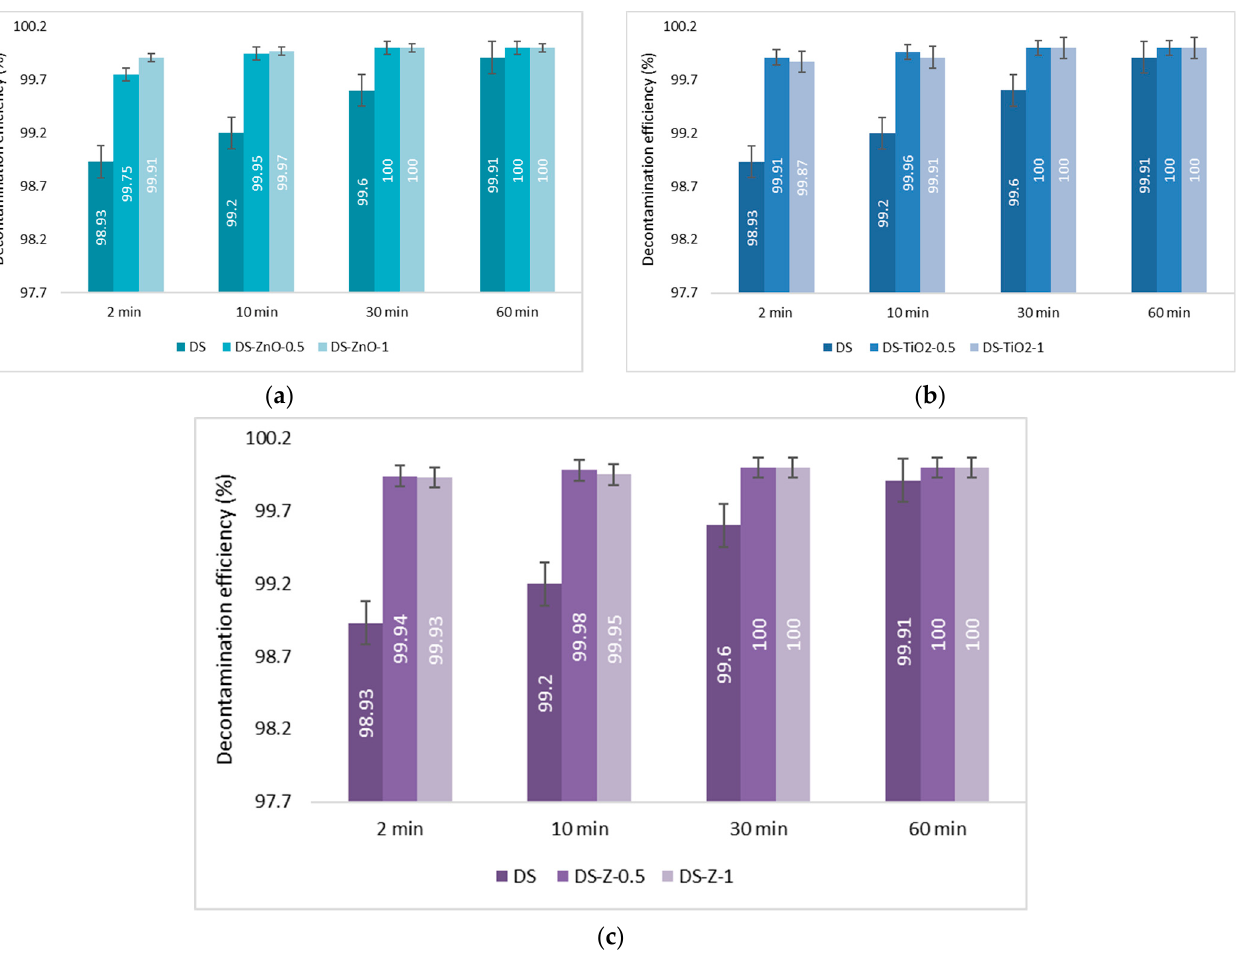
Figure 11. Decontamination degrees (%) of soman (GD) obtained for decontamination formulations containing: ( a ) ZnO, ( b ) TiO 2 , and ( c ) zeolite (detailed statistical data presented in Tables S9 and S10—Supplementary Material File).